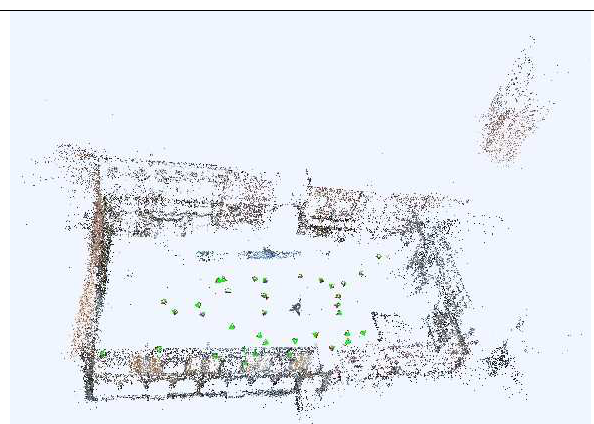
Figure 12. Results on